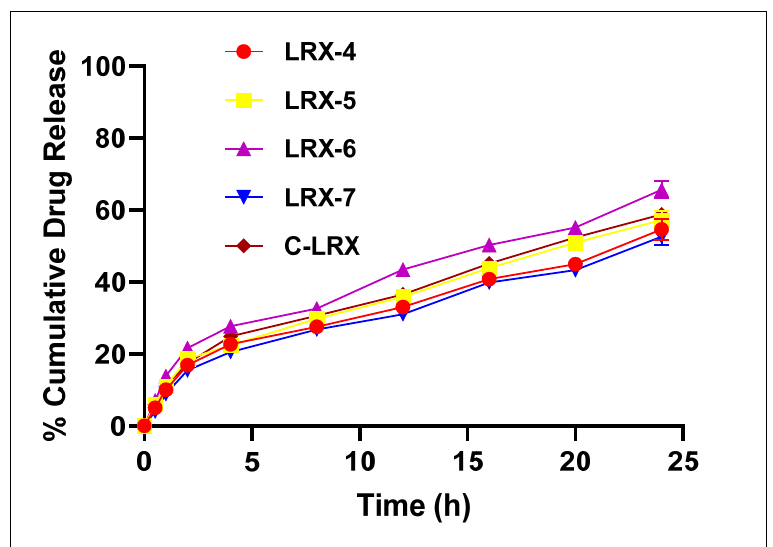
Figure 6. In vitro percent cumulative drug release from selected LRX-NE formulations.